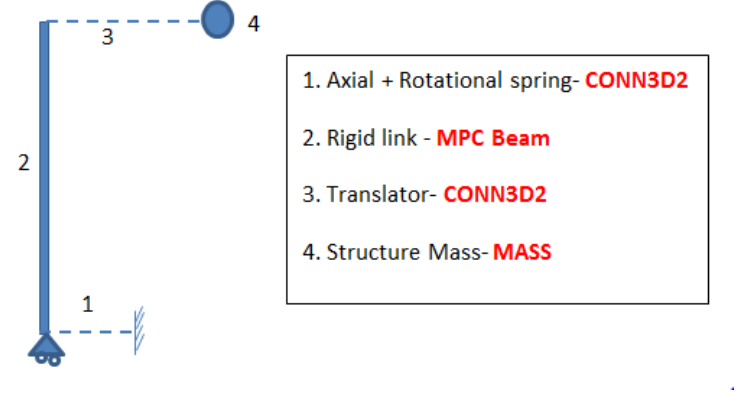
Figure 8. ABAQUS model of the dynamic system